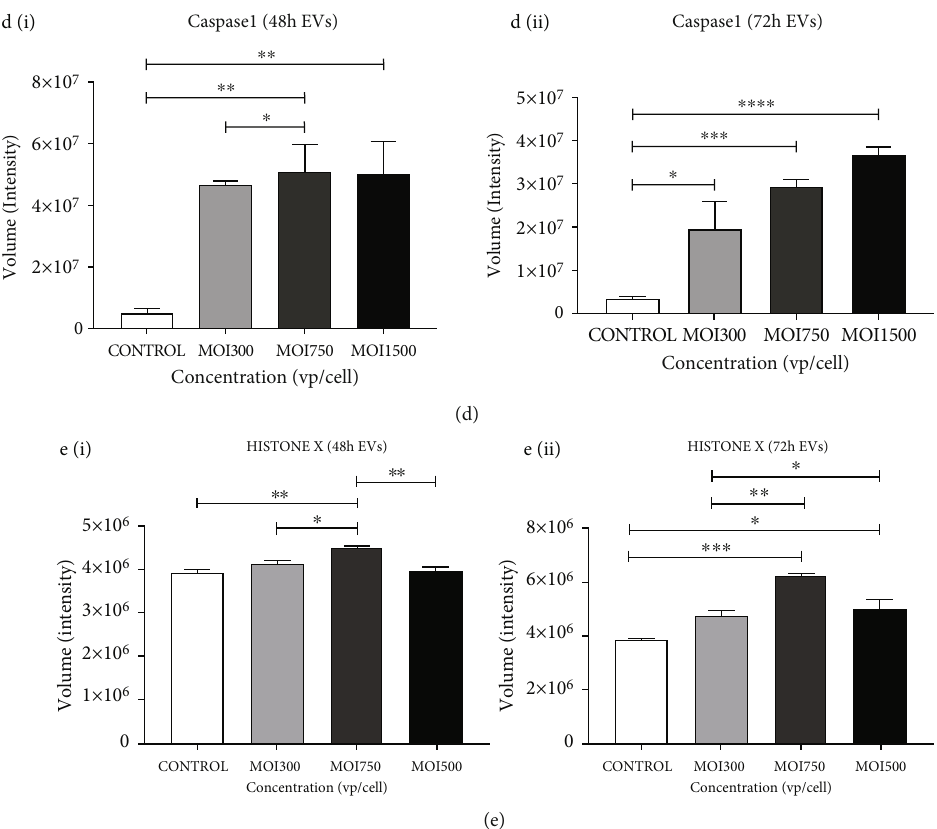
Figure 6: The e ff ect of HAdV3 infection on heat shock protein, Toll-like receptor, and caspase. Quanti fi cation of dot blot analysis showing expression of Hsp70, Hsp100, TLR7, caspase 1, and H2A-X expression after 48 h and 72h infection. EVs were probed for the presence of proteins. (a) (i) Graphs showing quanti fi cation of Hsp70 level after 48 h and (ii) 72h of infection. (b) (i) Hsp100 after 48h and (ii) 72h of infection. (c) (i) TLR7 after 48 h and (ii) 72 h of infection. (d) (i) Caspase 1 after 48 h and (ii) 72h of infection. (e) (i) H2A-X after 48h and (ii) 72h of infection. Dots shown in the fi gure are representative of four independent experiments. Data shows the mean ±